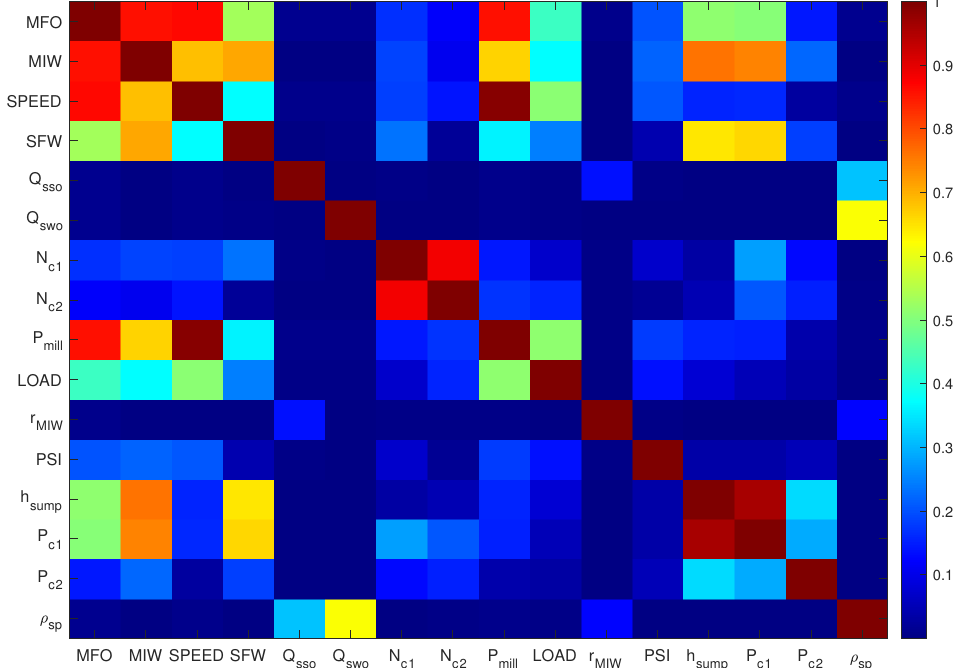
Figure 4. Cross-correlation plot for the complete data